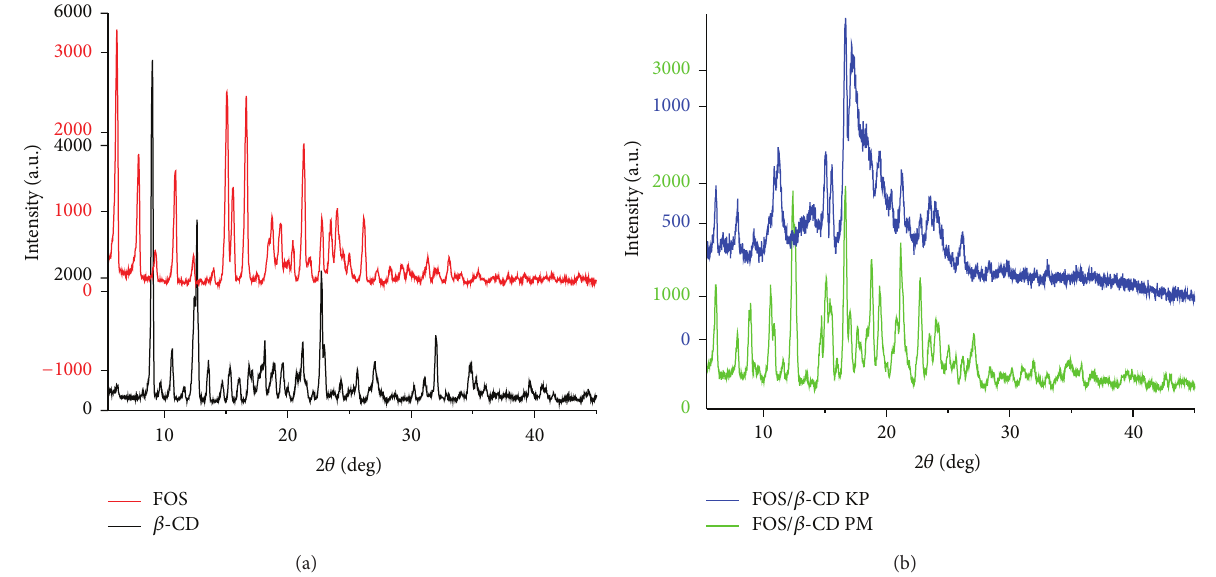
Figure 6: PXRD patterns of (a) FOS and 𝛽 -CD and (b) their binary